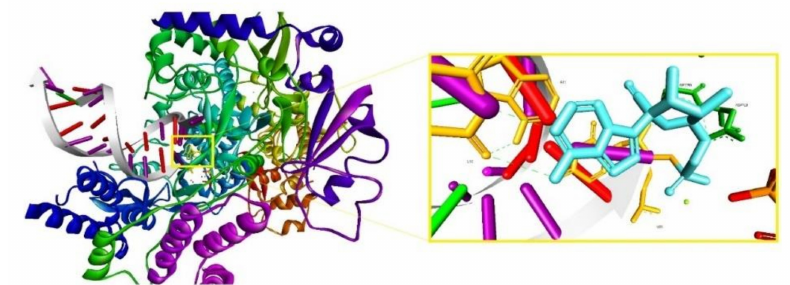
Figure 6. The nsp12-nsp7-nsp8 complex bound to the template-primer RNA and triphosphate form of RDV, Protein Data Base (PDB) ID: 7BV2 (left); RDV covalently bound to U20; hydrogen bonds are depicted as light green dotted lines, amino acid residues in dark green, and nucleotides in